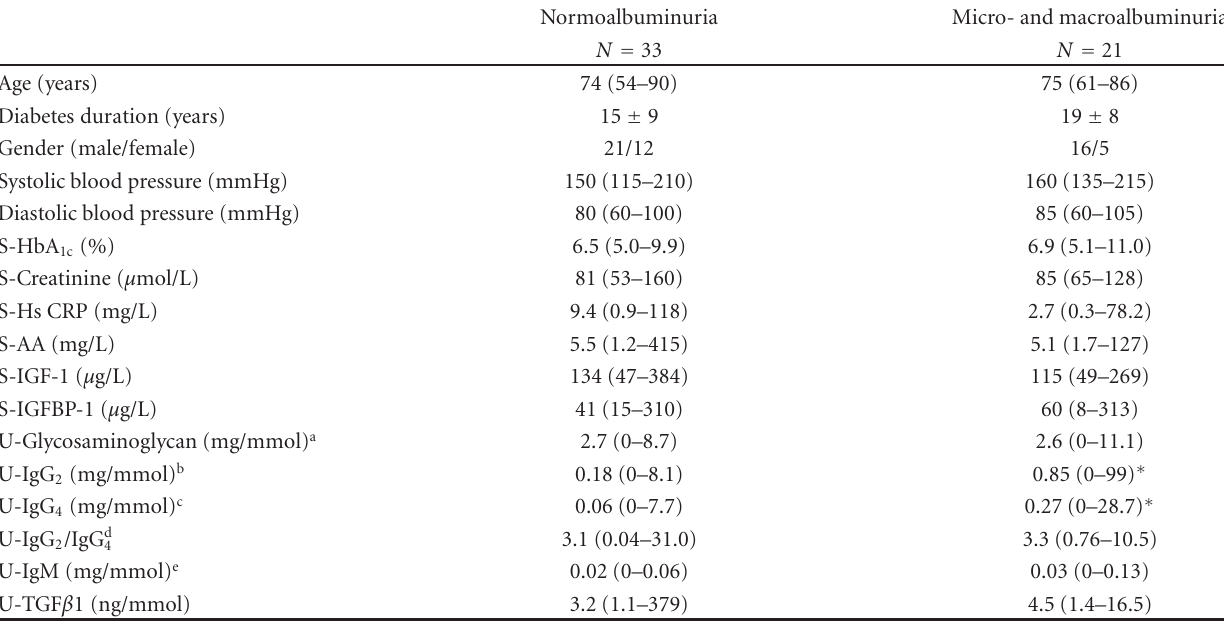
Table 2: Baseline values in patients grouped with normo- or micro- and macroalbuminuria.